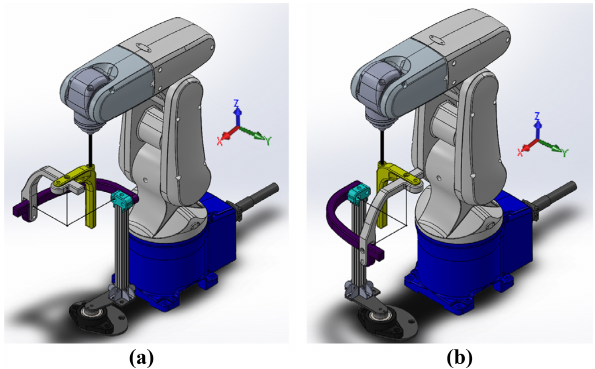
Figure 12. Human wrist positions.